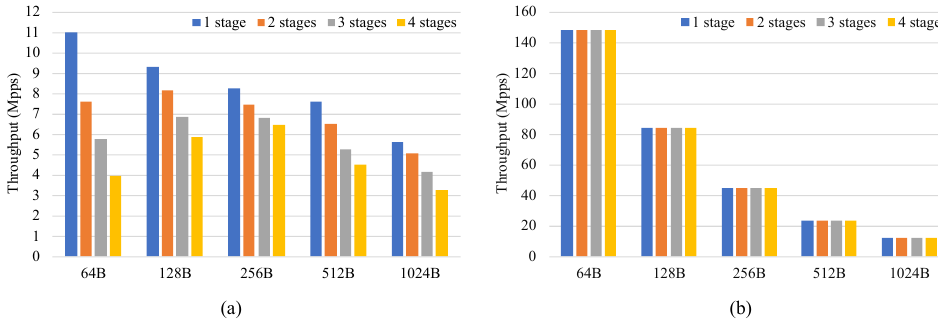
Figure 9. The throughput of the ( a ) CPU and ( b ) FPGA.